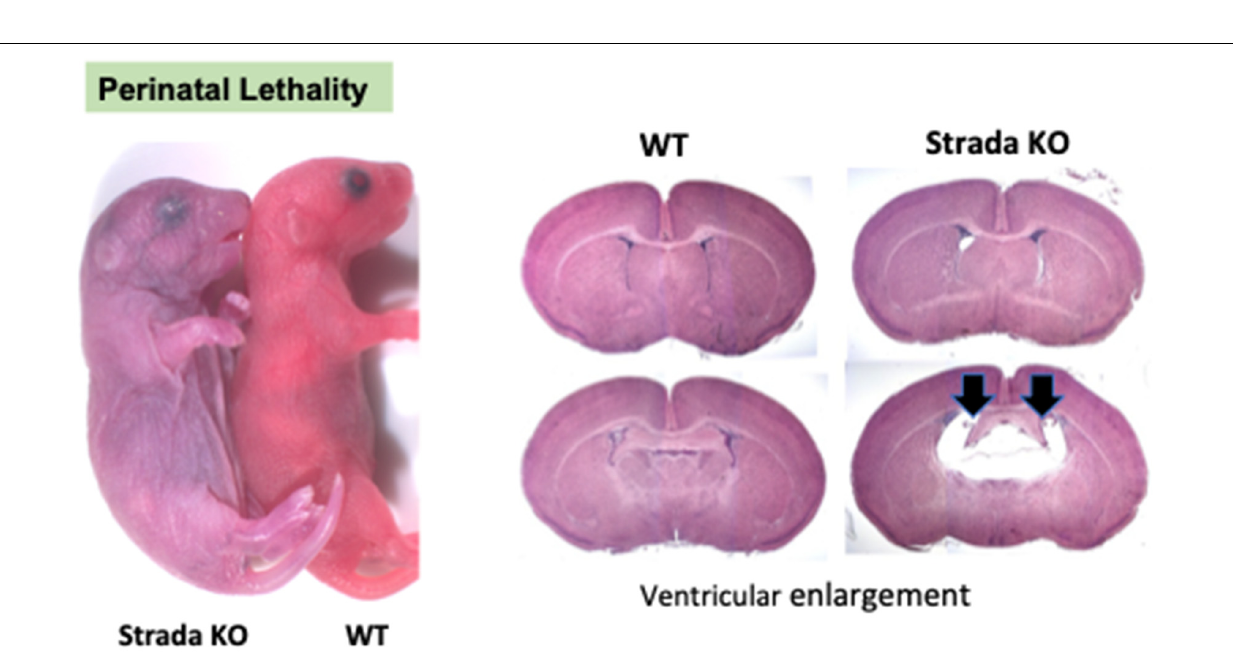
white matter were observed in Strada − / − brains analyzed at P9 as compared to littermate control WT ( Figure 9D